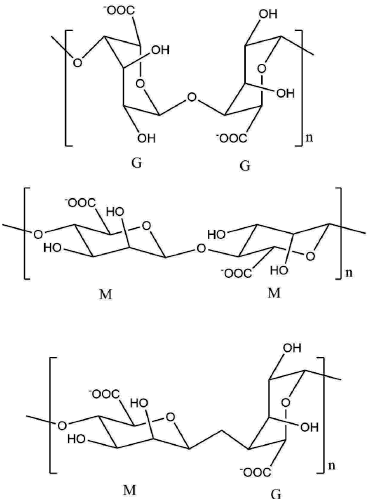
Figure 8. The chemical structures of three types of alginates.